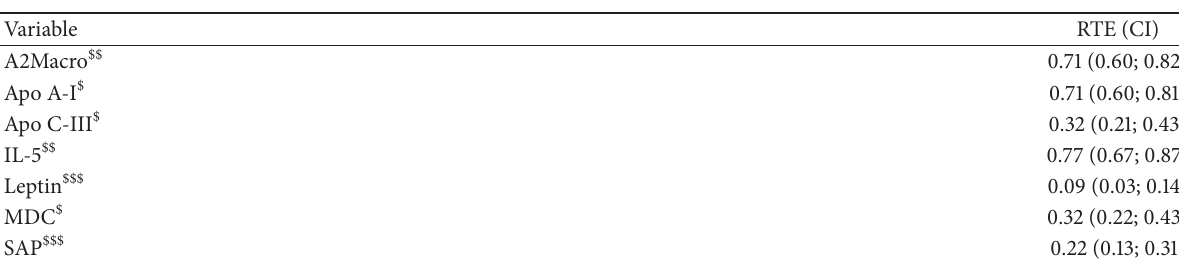
AFP = Alpha Fetoprotein; Apo H = Apolipoprotein H; BDNF = brain-derived neurotrophic factor; EN-RAGE: extracellular newly identified receptor for advanced glycation end-products binding protein; EGF = Epidermal Growth Factor; ENA-78 = epithelial-derived neutrophil-activating protein 78; G-CSF = granulocyte-colony stimulating factor; ICAM-1 = Intercellular Adhesion Molecule 1; IL-1 𝛽 = interleukin-1 beta; IL-1ra = interleukin-1 receptor antagonist; IL-16 = interleukin-16; IL-18 = interleukin-18; MIP-1 𝛽 = macrophage inflammatory protein-1 beta; MMP-9 = matrix metalloproteinase- 9; MPO = myeloperoxidase; PAI-1 = Plasminogen Activator Inhibitor-1; PAPP-A = Pregnancy Associated Plasma Protein-A; PAP = Prostatic Acid Phosphatase; RANTES = regulated upon activation normal T-cell expressed and secreted; SGOT = Serum Glutamic Oxaloacetic Transaminase; SCF = stem cell factor; TSH = Thyroid Stimulating Hormone; TBG = Thyroxine Binding Globulin; TIMP-1 = tissue inhibitor of metalloproteinase-1; VEGF = vascular endothelial growth factor; vWF = von Willebrand